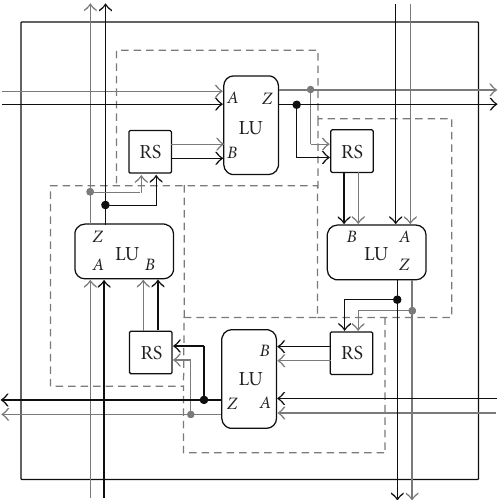
Figure 2: Logic units (LUs) and data latches (RS latches). To the A input and from the Z output, the black wires carry “1” pulses and the gray wires carry “0” pulses. To the B input, the black and gray wires are the Q and Q outputs, respectively, of the RS